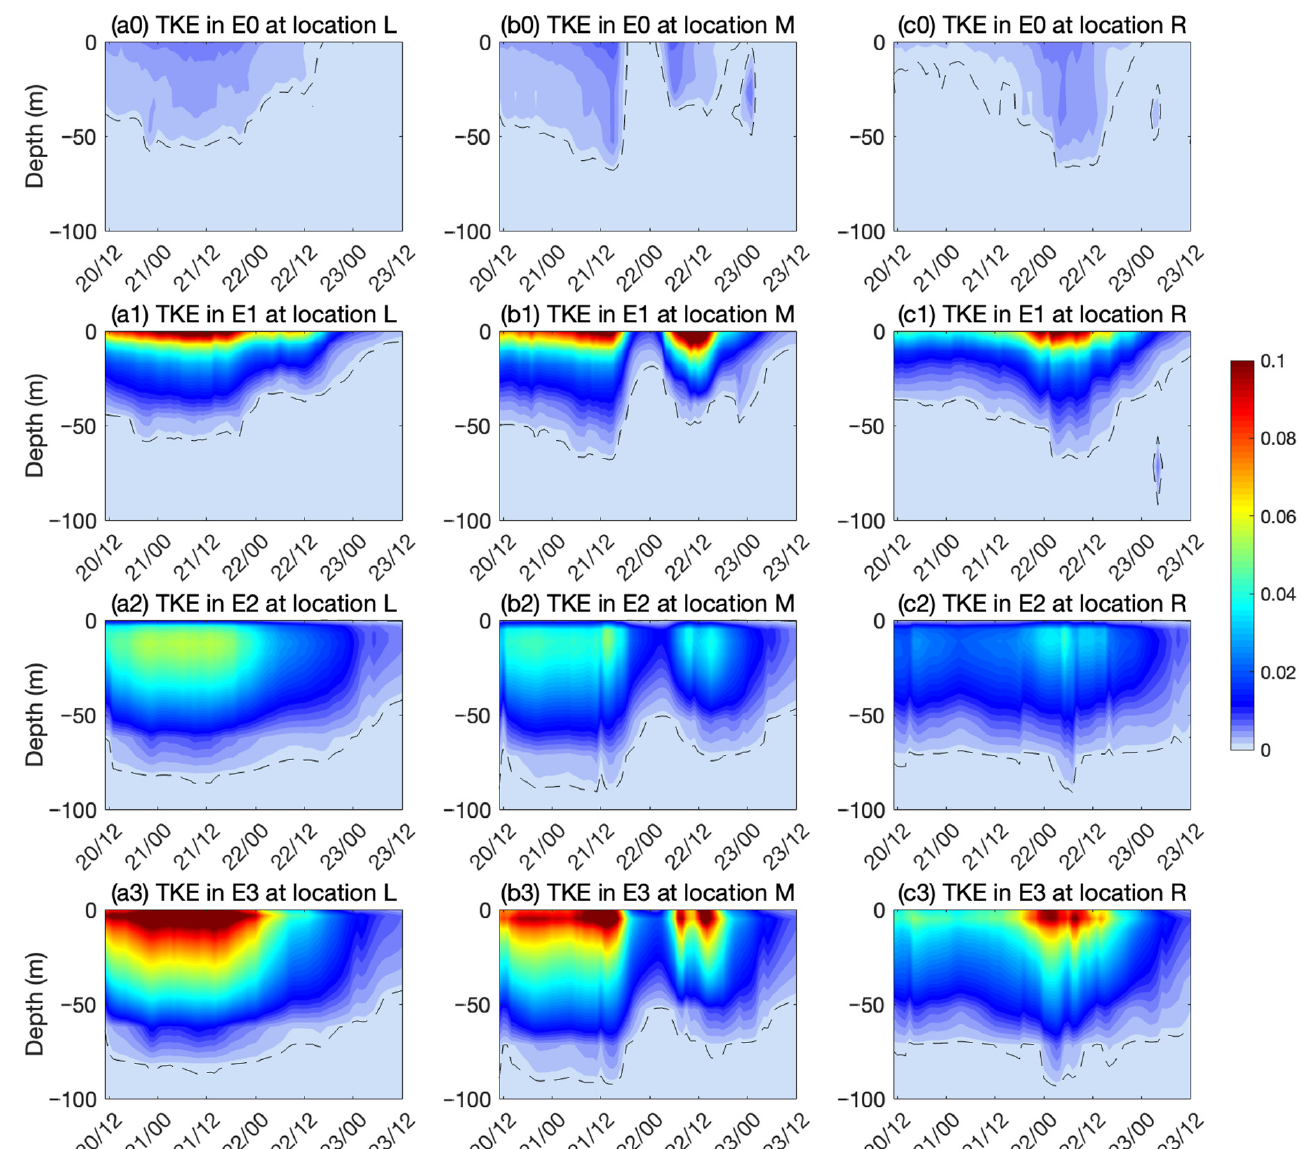
Figure 11. TKE (m 2 /s 2 ) among different experiments at locations of L, M, and R (indicated in Figure 10c). The black dashed lines represent the isoline of 1 × 10 − 3 m 2 /s 2 . Complex and frequently changing currents and waves occur under typhoon forcing.